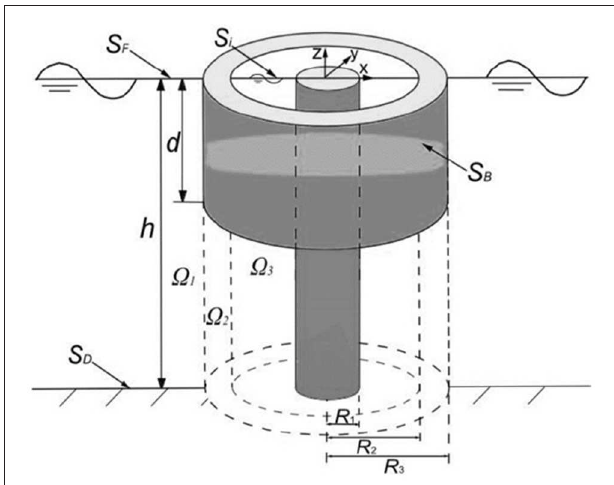
FIGURE 3 | Underwater part